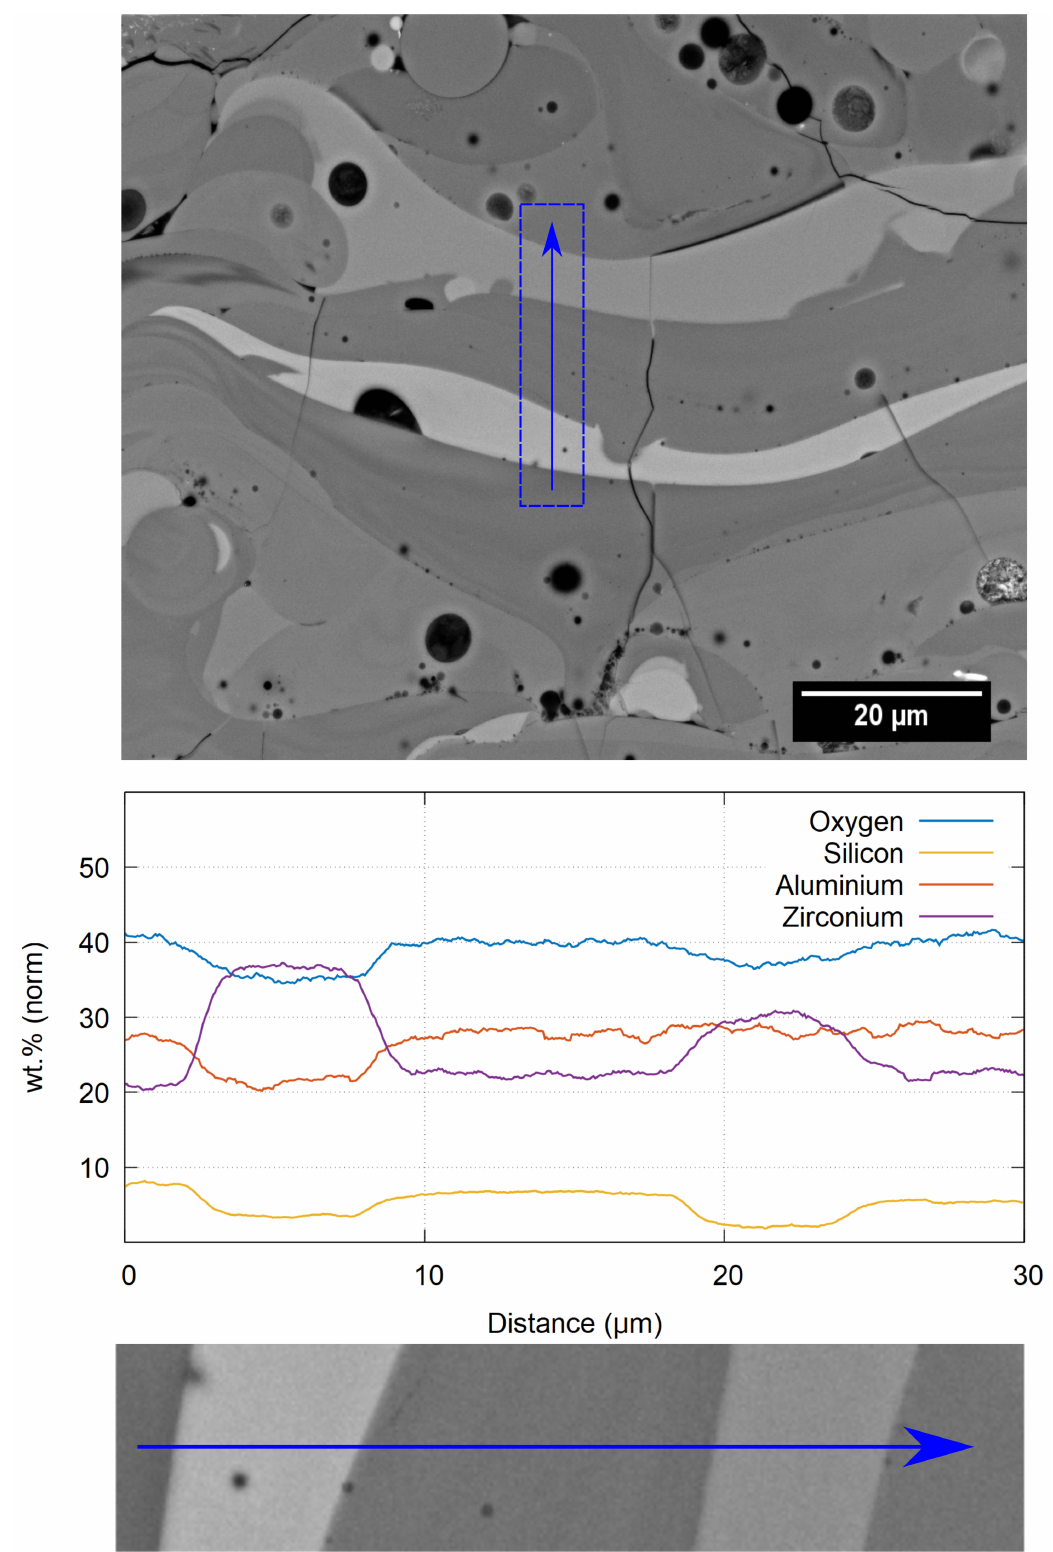
Figure 3. Local EDX line analysis of the splats in the as-sprayed material.